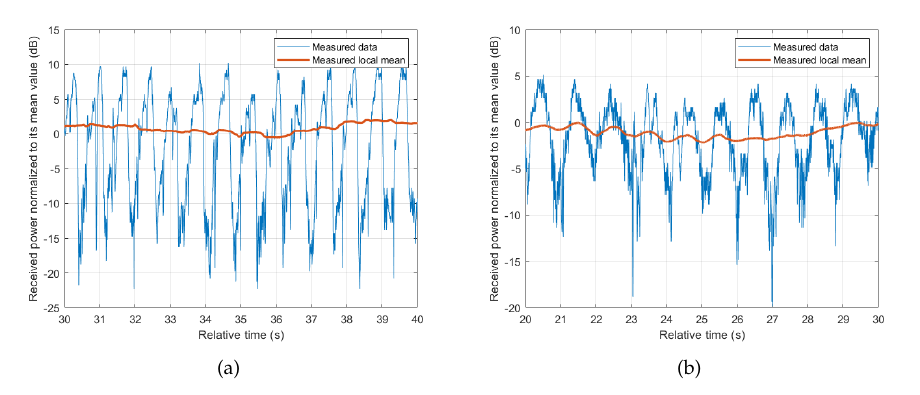
Figure 3. Example of measured time series collected in Scenario 1, (subject behind the other).